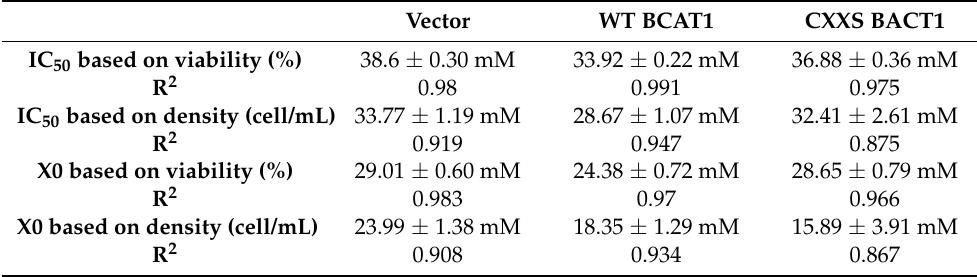
Figure 6. The effect of Gabapentin on Vector Control, WT BACT1, and CXXS BACT1 U937 cells. Vector Control, WT BCAT1, and CXXS BCAT1 overexpressing U937 cells were incubated with Gabapentin at increasing concentrations and monitored for cell density and cell viability. ( a ) Data illustrate the IC 50 for Gabapentin with respect to cell viability (%) and ( b ) cell density. ( c ) Direct comparison of IC 50 and minimum inhibitory concentration (X0) for each cell line as determined by viability (%). ( d ) Direct comparison of IC 50 and X0 for each cell line as determined by cell density. Data presented are mean ± SD ( n = 3). Significant differences were calculated using 1-way ANOVA with Tukey’s post-test. * p < 0.05 ( n = 3). Table 1. Gabapentin IC 50 (mM) and X0 (mM) for Transformed U937 Cells. IC 50 was determined by non-linear regression using Log10 [Gabapentin]. Minimum inhibitory concentration (X0) was determined by non-linear regression, using the plateau followed by one phase death decay model. Respective R2 values are presented